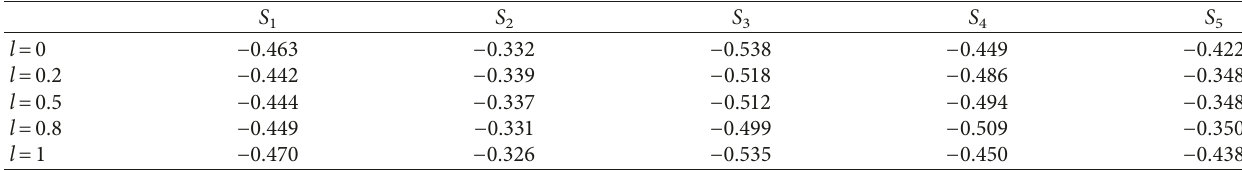
Table 5: Scoring functions of the comprehensive values for dynamic ATS-GWIFBM operator.